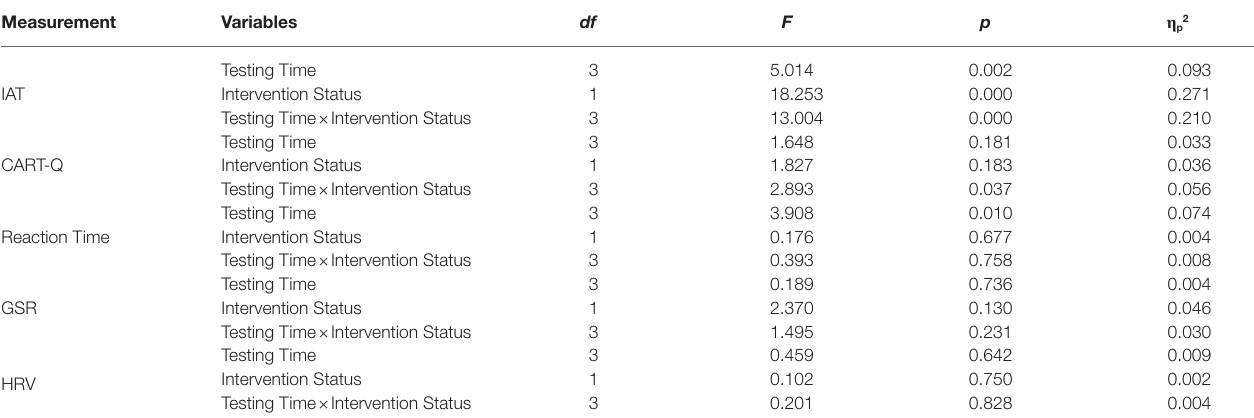
TABLE 3 | The Analysis of Variance Statistics for the Implicit Association Test (IAT), the Coach–Athlete Relationship Questionnaire (CART-Q), and the Athletes’ Reaction Time, Galvanic Skin Response (GSR) and SDNN Measure of the Heart Rate Variability (HRV) When Viewing the Coaches’ Faces.